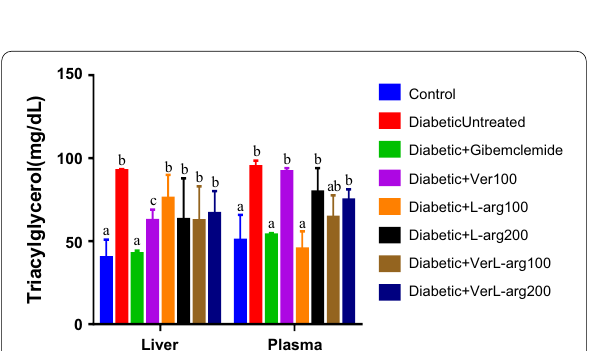
Fig. 8 Triacylglycerides concentration in diabetic mice treated with verbenone, L-arginine and ratios of verbenone After 14 days treatment. Values are expressed as mean Values with different superscripts are significantly different at p < 0.05. VerL-arg verbenone L-arginine (1:1 v/m) = +